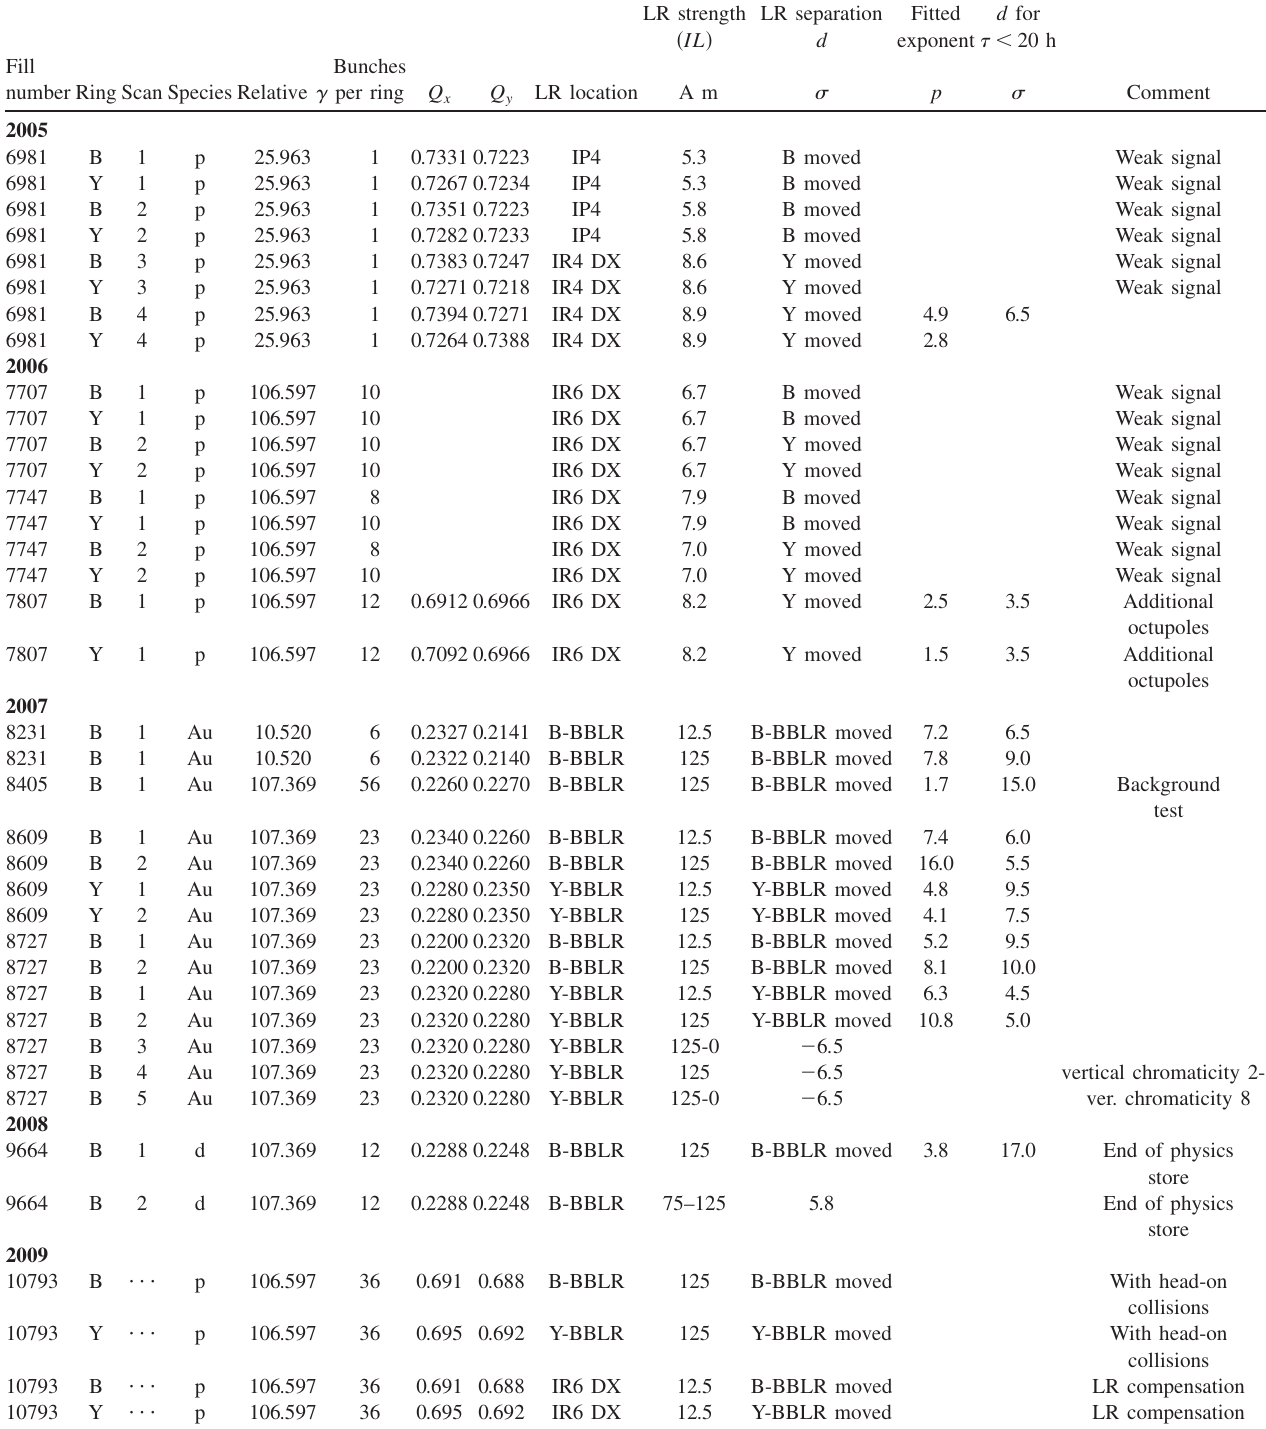
TABLE III. Summary of long-range beam-beam experiments in RHIC. The wires in the Blue and Yellow ring are named B-BBLR and Y-BBLR, respectively. Fields are left blank when the experimental value could not be determined. LR strength LR separation Fitted d for ð IL Þ exponent (cid:9) < 20